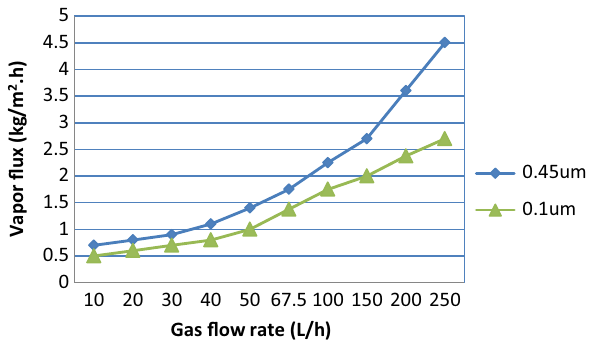
Fig. 13 Effect of liquid flow rate on vapor flux in membrane evapo- ration as the sweeping gas; inlet gas temperature 21 °C; evaporation temperature 45 °C; gas flow rate 60 L/h; gas side pressure 0; liquid side pressure 13.8